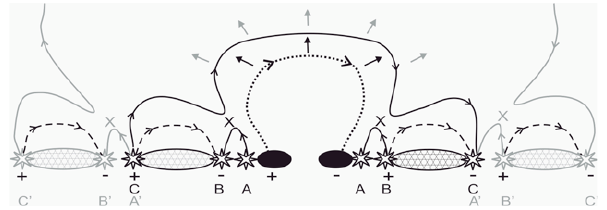
Fig. 10. Cartoon illustrating the magnetic reconnection between CME and the magnetic carpet proposed by Attrill et al. (2007a). The expanding CME (dotted line) reconnects with favourably oriented quiet-Sun magnetic loops (dashed lines), displacing the footpoints of the expanding CME (solid line). The crosses mark regions where magnetic reconnection occurs. The dotted/dashed lines show the pre-eruption magnetic structures, the black (gray) solid lines show the result of the first (subsequent) reconnections. This model pro- vides a new explanation for the so-called “EIT-wave” phenomenon (its diffuse variety) and also explains the formation of wide-spread shallow dimming behind the wave